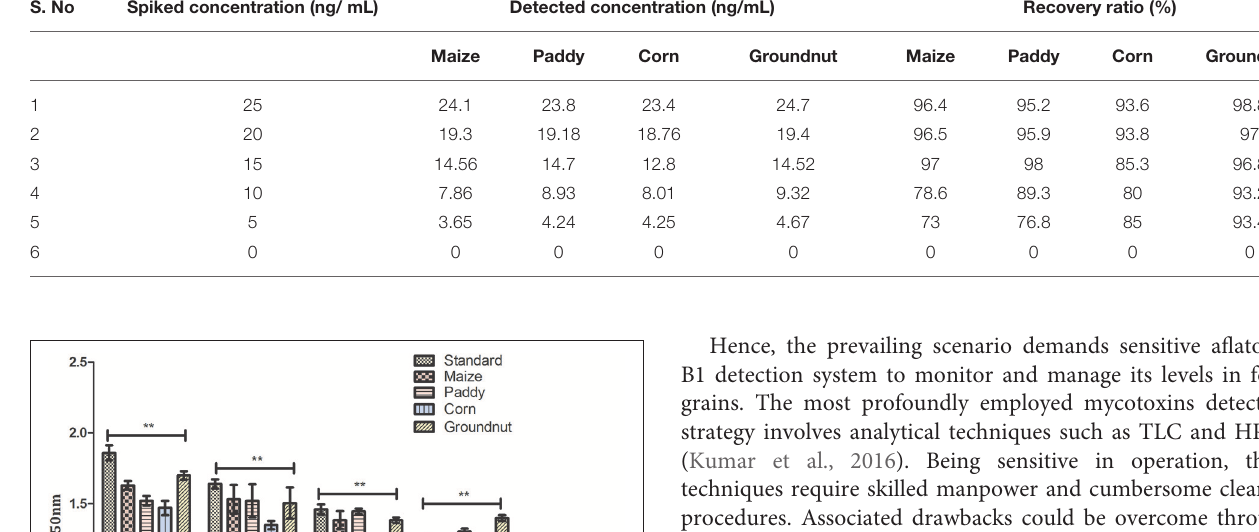
TABLE 3 | Recovery result of aflatoxin B1 spiked food samples detected by developed hybrid sandwich assay. S. No Spiked concentration (ng/ mL)